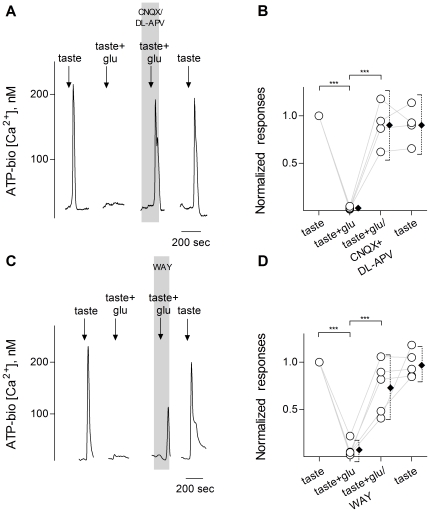
Serotonin, released during glutamate stimulation, inhibits taste buds.ATP biosensors were used to monitor taste-evoked transmitter release from taste buds. A, Traces show responses from a biosensor positioned near an isolated taste bud to measure ATP release elicited by taste stimulation. A sweet-bitter taste mix (↓, taste; 1 mM sucralose, 0.1 mM SC45647, 10 µM cycloheximide, 1 mM denatonium) evoked ATP release (biosensor response) that was inhibited by 100 µM glutamate (↓, taste+glu). Glutamate-evoked inhibition of ATP secretion was fully restored by adding combination of CNQX (30 nM) and DL-APV (15 µM) (present throughout the shaded area) to the bath. B, Summary of data. Open circles show normalized peak biosensor responses triggered by taste, taste+glutamate, taste+glutamate in the presence of CNQX and DL-APV, and finally, a repeat taste stimulus. As in Fig. 2, offset filled symbols show mean ± 95% CI, ***, p<0.001, repeated measures ANOVA, N = 4). C, In another experiment, a sweet-bitter taste mix (↓, taste) evoked ATP release (biosensor response) that was inhibited by 100 µM glutamate (↓, taste+glu). Glutamate-evoked inhibition of ATP secretion was partially reversed by adding WAY100635 (WAY, 10 nM, present throughout the shaded area), a 5-HT1A antagonist, to the bath. D, Summary of data. Open circles show normalized peak biosensor responses of each experiment triggered by taste, taste+glutamate, and finally taste+glutamate in the presence of WAY100635. Offset closed symbols show mean ± 95% CI. ***, p<0.001, repeated measures ANOVA, N = 5).